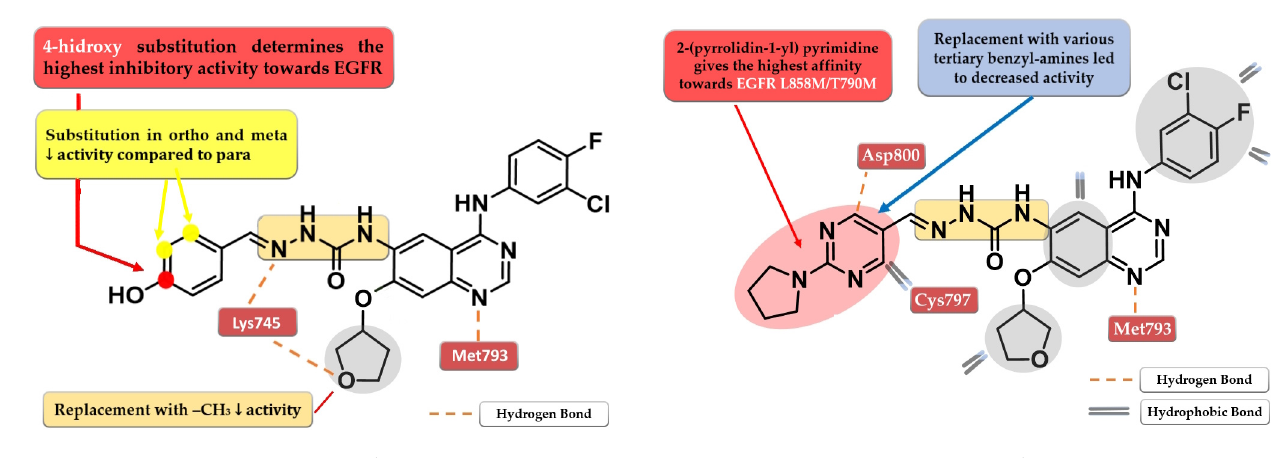
Figure 4. Structure–activity relationship and molecular docking of compound 3 in the human EGFR T790M kinase domain (PDB ID 4G5J) [108], as reported by Tu et al. [106]; structure–activity relationship and molecular docking of compound 4 in the human EGFR T790M kinase domain (PDB ID 4G5J) [108], as reported by Wang et al.